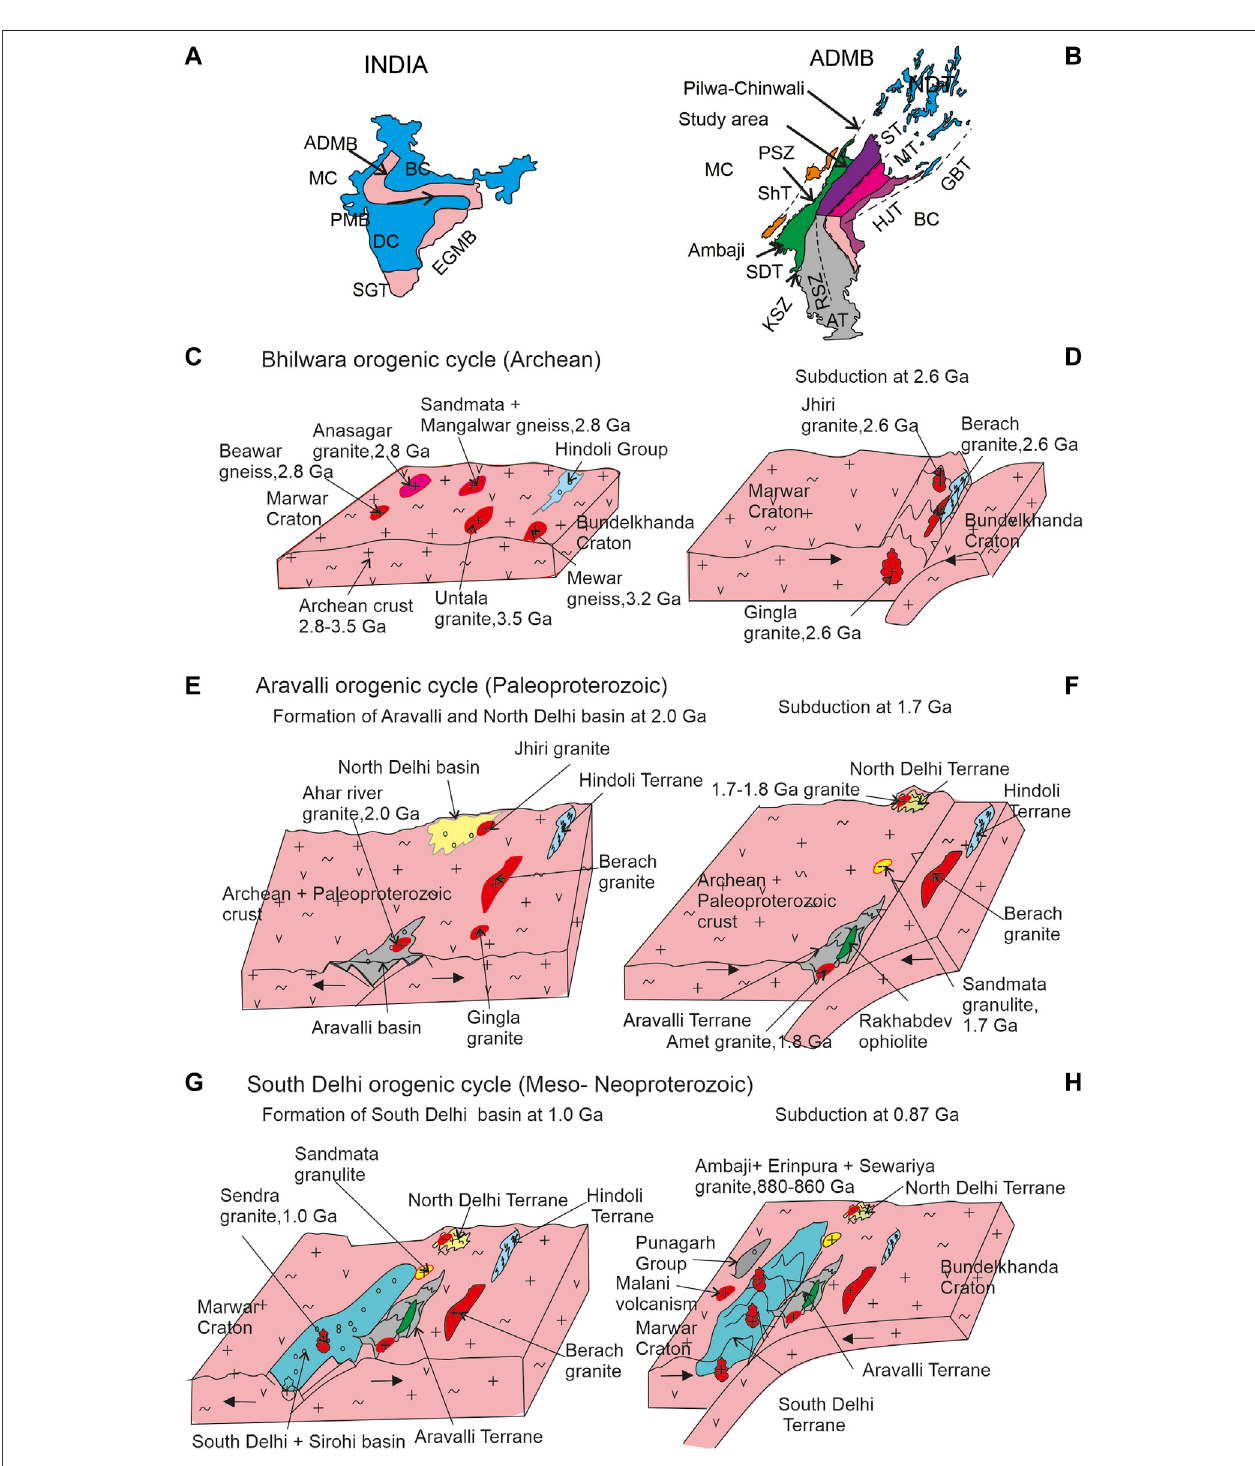
FIGURE1|(A) Peninsular India withlocationofvarious cratons and mobilebelts. Abbreviations:ADMB: Aravalli-Delhi MobileBelt, BC:BundelkhandaCraton, DC: Dharwar Craton, EGMB: Eastern Ghats Mobile Belt, MC: Marwar Craton, PMB: Proterozoic mobile belt, SGT: Southern Granulite terrane. (B) Simpli fi ed terrane map of the ADMB (Singh et al., 2010). Abbreviations: AT: Aravalli Terrane, BC: Bundelkhanda Craton, GBT: Great Boundary Thrust, HJT: Hindoli-Jahazpur Terrane, KSZ: Kaliguman Shear Zone, MT: Mangalwar Terrane, MC: Marwar Craton, NDT: North Delhi Terrane, PSZ: Phulad Shear Zone, RSZ: Rakhabdev shear zone, SDT: South Delhi Terrane, ShT: Sirohi Terrane. (C) Schematic diagram of the Bhilwara, Aravalli, and South Delhi orogenic cycles: The Archean crust was 2.8 – 3.5 Ga old, the relicts are left out as Mewar gneiss, Untala granite, Beawar gneiss, and Sandmata-Mangalwar gneisses. Hindoli group was probably a greenstone belt; all these were